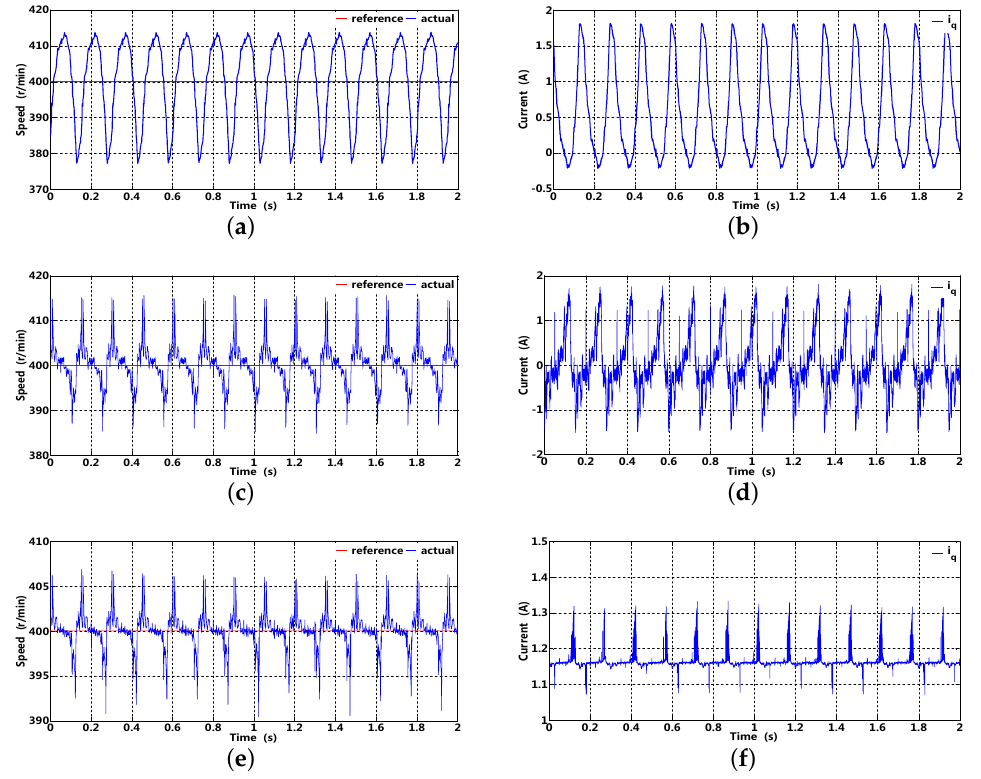
Figure 20. Speed and corresponding q -axis current based on original PI controller (without q -axis current compensation), DOB and ARRC (20 Hz): ( a , b ) speed and corresponding q -axis current with an original PI controller; ( c , d ) speed and corresponding q -axis current with DOB; ( e , f ) speed and corresponding q -axis current with